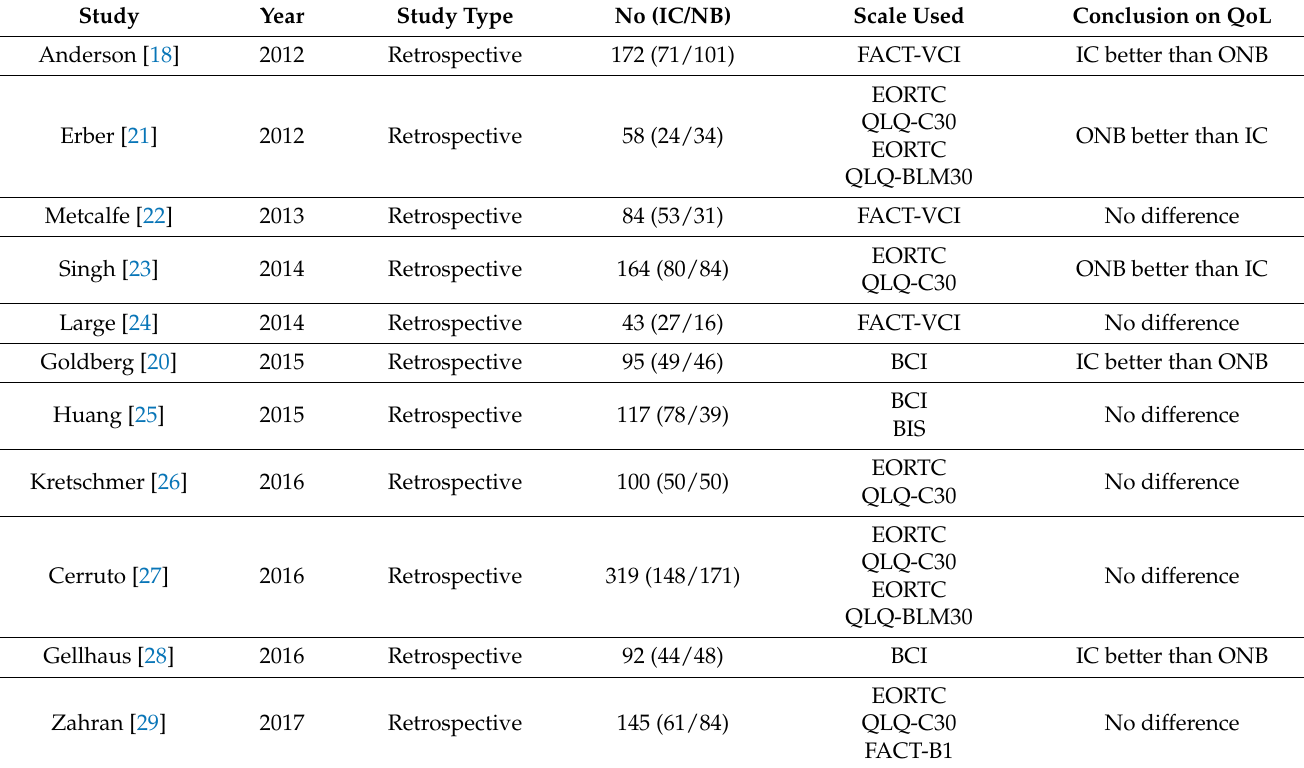
Table 1. Characteristics of included